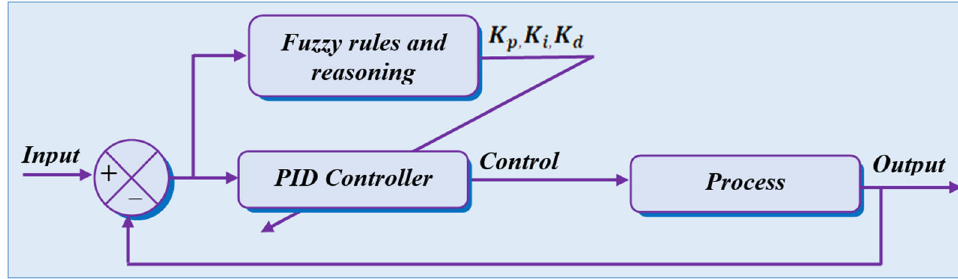
Figure 9. PID control system with fuzzy logic controller.